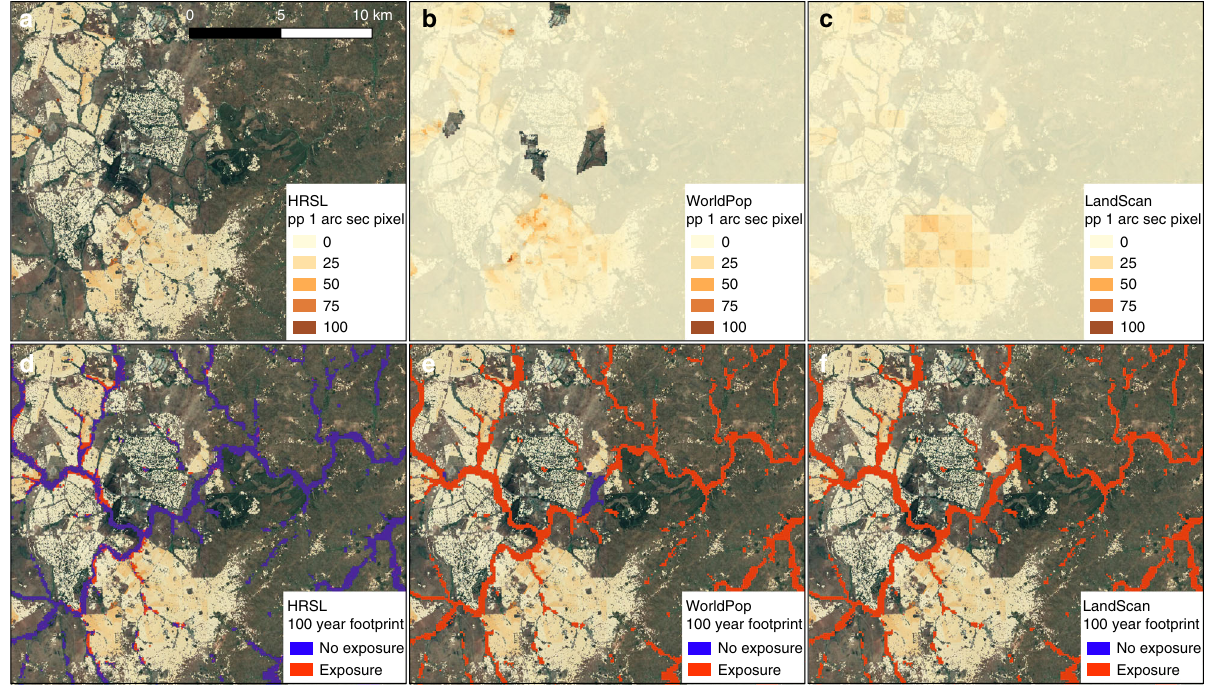
Fig. 2 Example of Exposure Mapping in Malawi. Example of population data and generated exposure maps for Lilongwe city, in Malawi. a , b , c display the HRSL, WorldPop, and LandScan ™ population data sets, respectively. d , e , f show the population located in the 100 year fl oodplain for each demographic data set, respectively